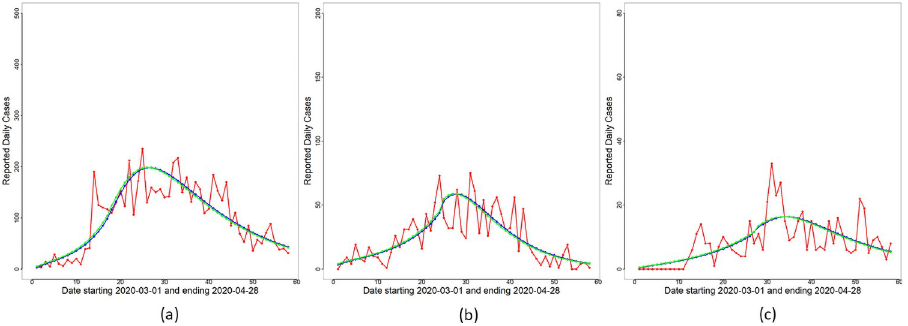
Fig 5. Modified SEIR model: Daily cases. Reported daily cases (red line), and overlay plots of Δ R o ( t ) (blue line) and F ( t ) (green line) based on ^ Y for (a) Malaysia, (b) Selangor and (c) Sarawak. MAP